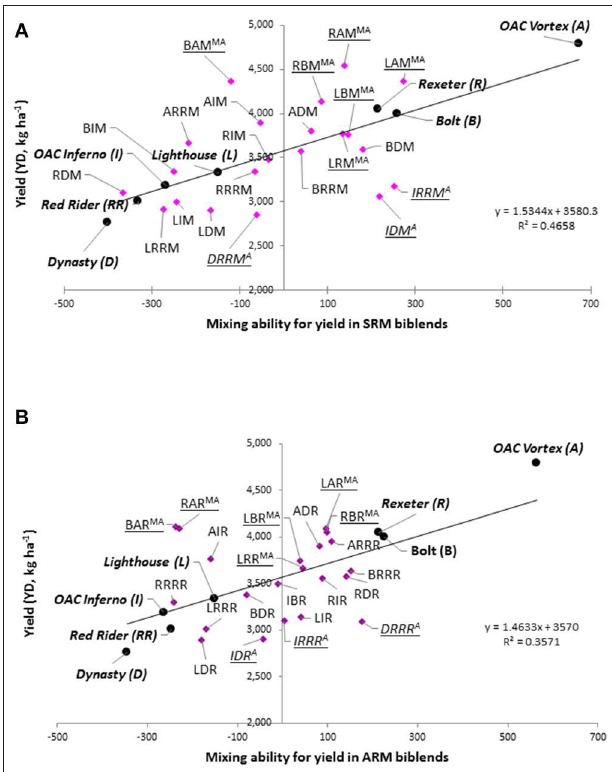
FIGURE 8 | Relationships between yield and mixing abilities [General Mixing Abilities (GMA) and Specific Mixing Abilities (SMA)] in common bean cultivar mixtures. (A) Same row mixtures (SRM); (B) Alternate rows mixtures